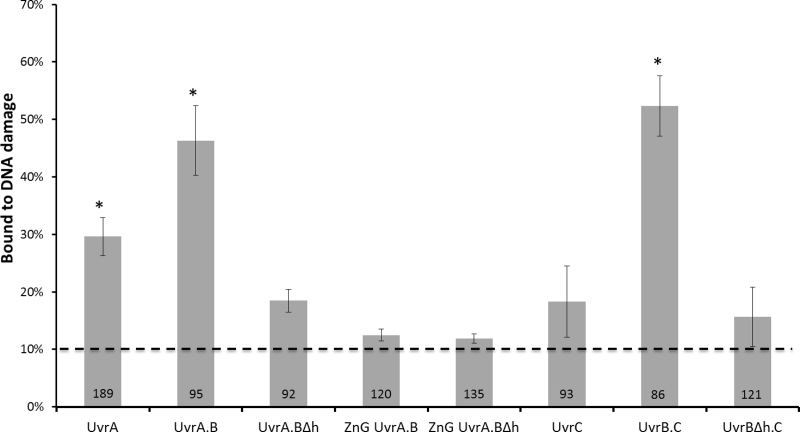
Probability of finding a Uvr protein complex colocalized with a damage marker. Values for mean probability percentage (±SEM, where, n refers to repeated experiments) bound to damaged DNA were 30% (±3% n = 5), 46% (±6% n = 4), 18% (±2% n = 4), 12.5% (±1% n = 3), 12% (±0.8% n = 3), 18% (±6% n = 3), 52% (±5% n = 4) and 15% (±5% n = 5) for UvrA, UvrA.B, UvrA.BΔh, ZnG UvrA.B, ZnG UvrA.BΔh, UvrC, UvrB.C and UvrBΔh.C, respectively. These data are summarized in Supplementary Table S1. The dashed line represents the probability (10.1%) of random association to damage based upon UvrA-Qdot binding to the mid-point of a DNA tightrope. *Indicates statistically significantly difference (P < 0.05) relative to the 10.1% random association value. UvrA.B and UvrB.C are not statistically different (P > 0.47). UvrA.BΔh, ZnG UvrA.B, ZnG UvrA.BΔh, UvrC and UvrBΔh.C are not statistically different to each other and the random association probability (P > 0.37). UvrA is statistically distinct from the UvrA.B/UvrB.C group (P < 0.01) and the Uvr mutant group with UvrC (P < 0.01).